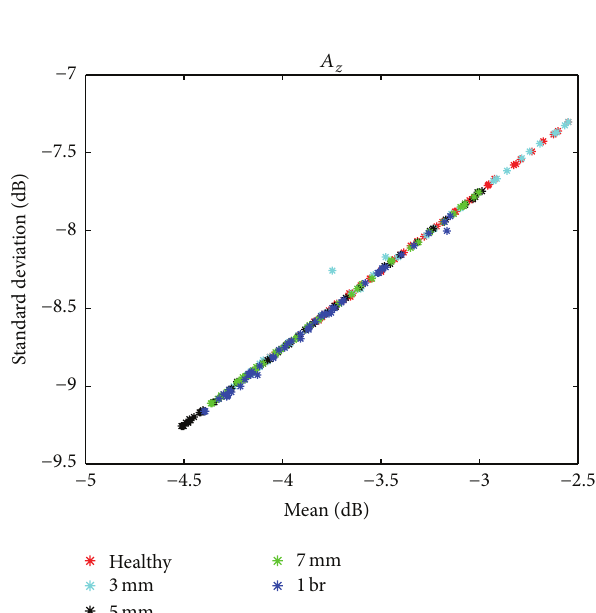
Figure 11: Half-load condition analysis, 𝐴 𝑧 -axis.